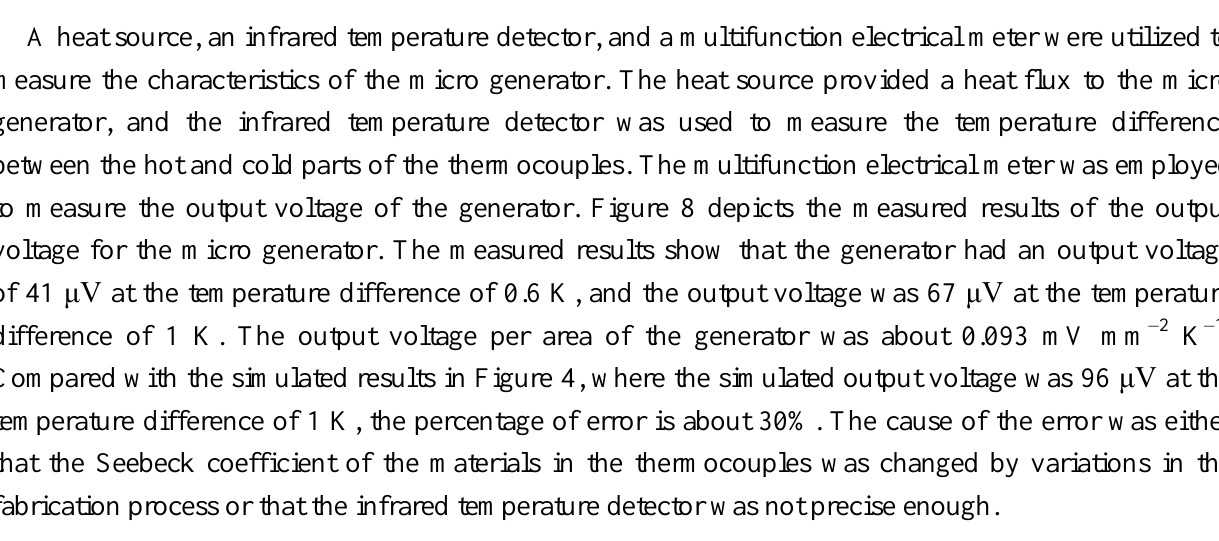
Figure 8. Output voltage of the